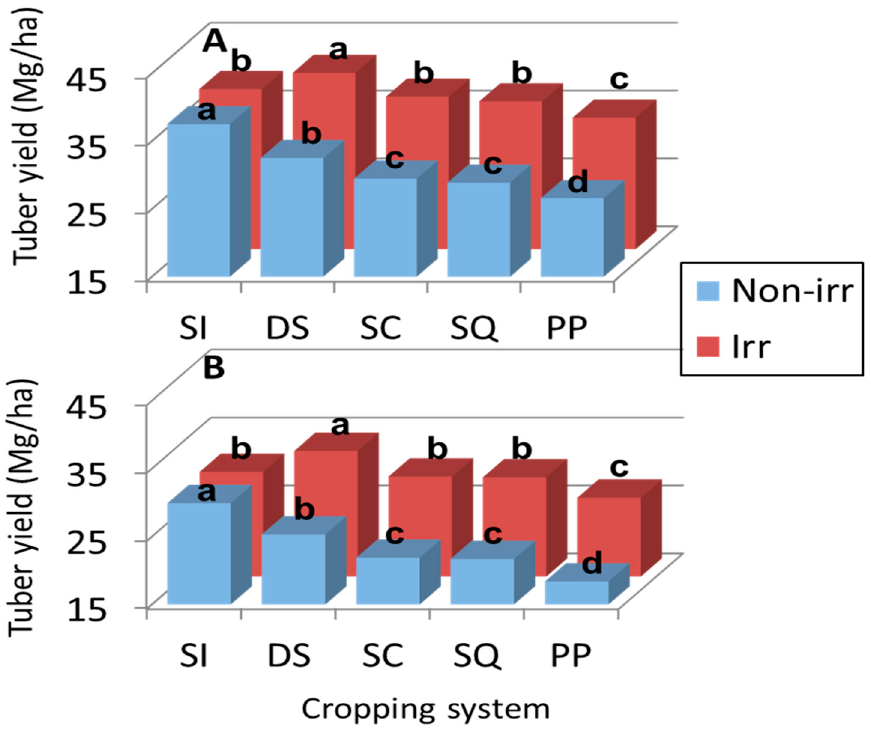
Figure 1. Effects of cropping system (SQ—standard rotation, SC—soil conserving, SI—soil improving, DS—disease suppressive, and PP—nonrotation control) and irrigation (Non-irr = Non-irrigated and Irr = Irrigated) on average ( A ) total and ( B ) marketable tuber yield over a 5 year period (2006–2010). Bars topped by the same letter within each irrigation regime are not significantly different from each other based on ANOVA and Fisher’s protected LSD test ( p <